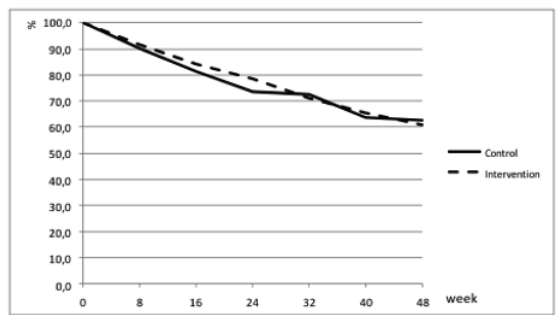
Figure 1. The rate of patients continuing statin therapy over time, by study group.